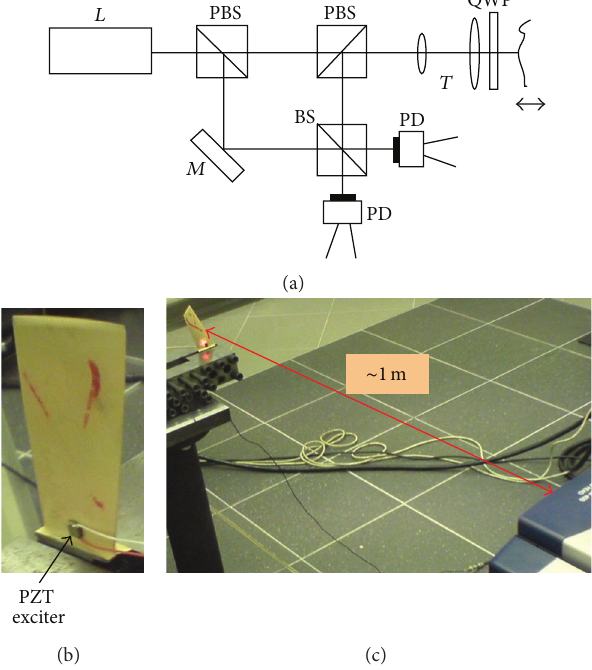
Figure 17: Experimental stand for the broadband (up to 20kHz) modal identification of the compressor blade with the use of scanning laser vibrometer and PZT exciter.